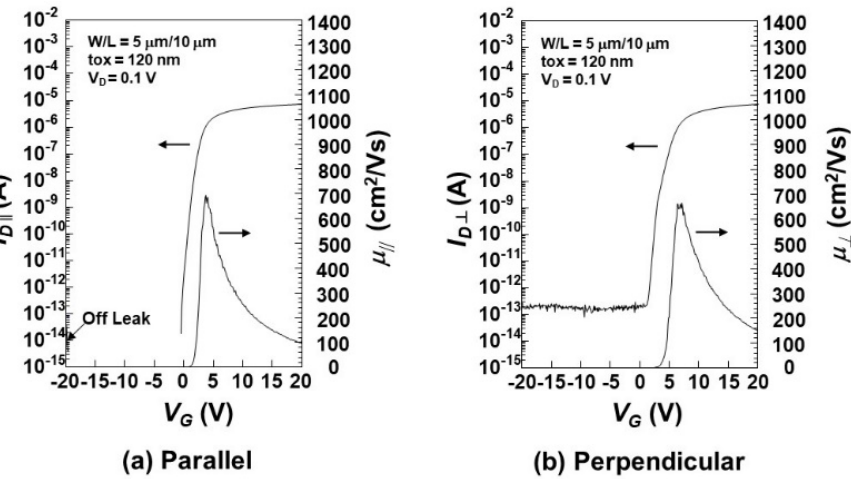
Figure 8. Drain currents I D and effective field-effect mobilities µ as a function of the gate voltage V G for the parallel and perpendicular TFT, respectively. ( a ) The parallel TFT with maximum mobility and ( b ) the perpendicular TFT with maximum mobility. Drain voltage V D was 0.1 V. The maximum values of field-effect mobilities were µ (cid:107) = 695 cm 2 /Vs and µ ⊥ = 663 cm 2